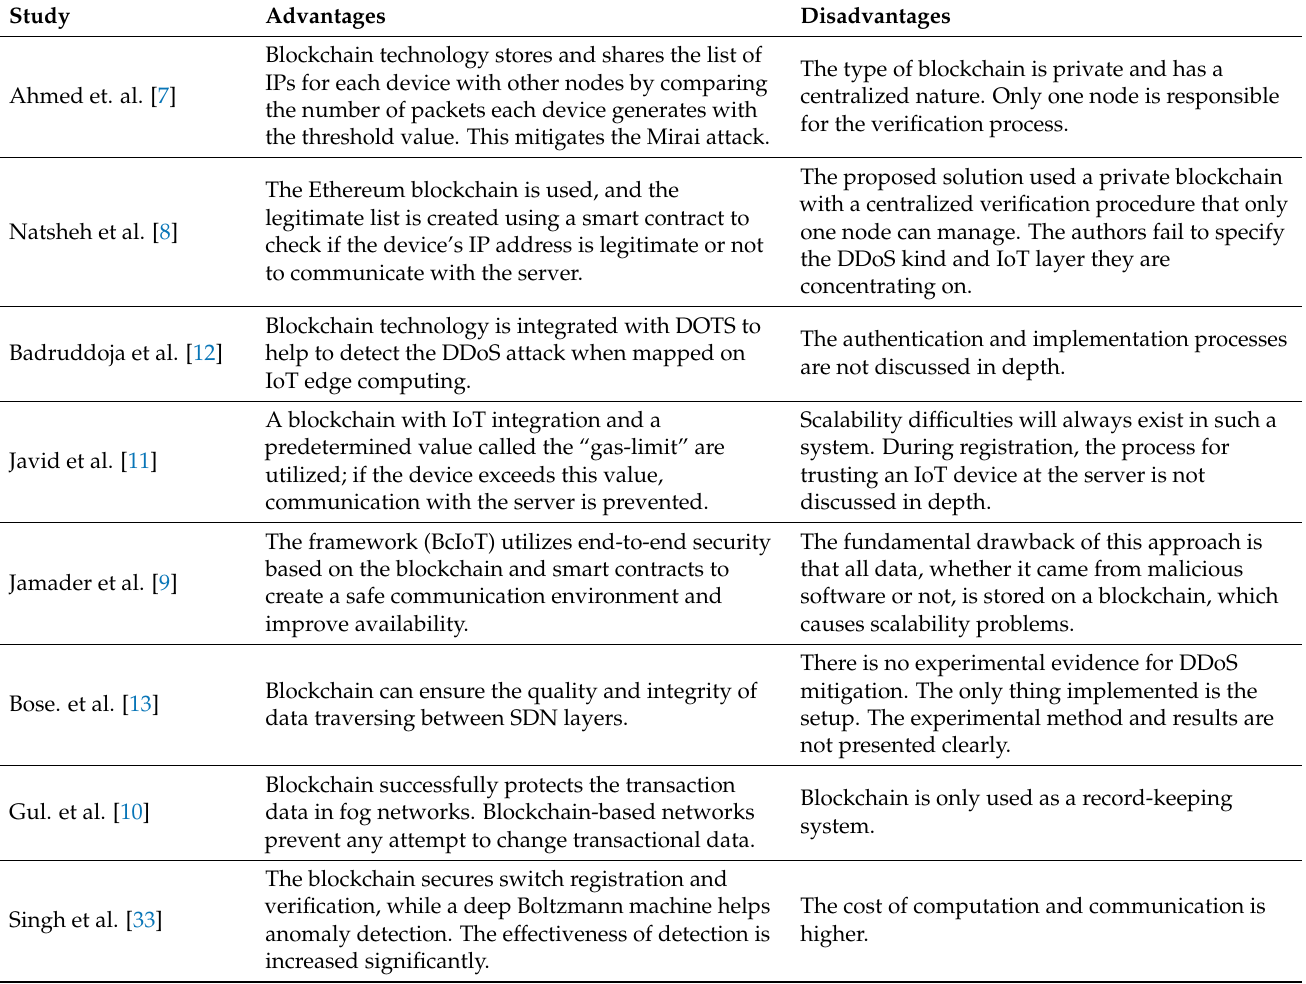
Table 1. Blockchain solutions (advantages and